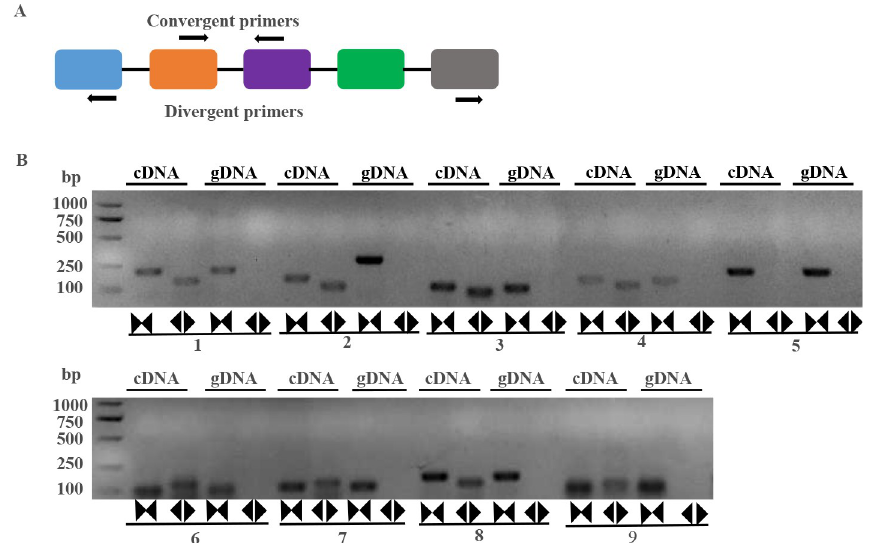
Fig 3. Validation of maize circRNAs. Validation of circular RNAs (circRNAs) by PCR amplifications with divergent primers in maize. (A) Divergent and convergent primers for amplification of circRNA and linear RNA are shown in a model, respectively. (B) A set of divergent primers (black back-to-back triangle pairs) successfully amplified eight circRNAs in cDNA. A set of convergent primers (black opposing triangle pairs) could work on both cDNA